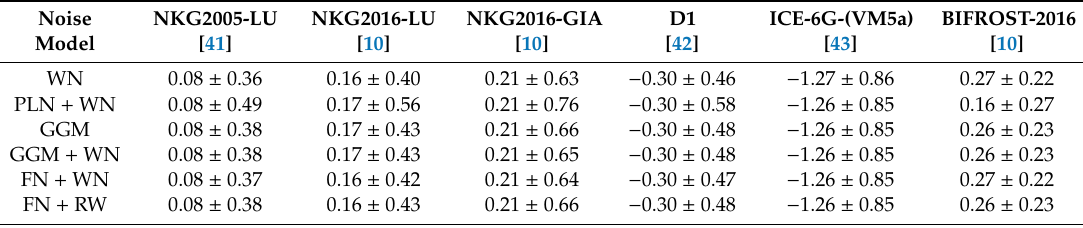
Table 5. The mean and standard deviation in mm/yr of the Up velocity residuals from different LU and GIA models based on the solution GOA_2.